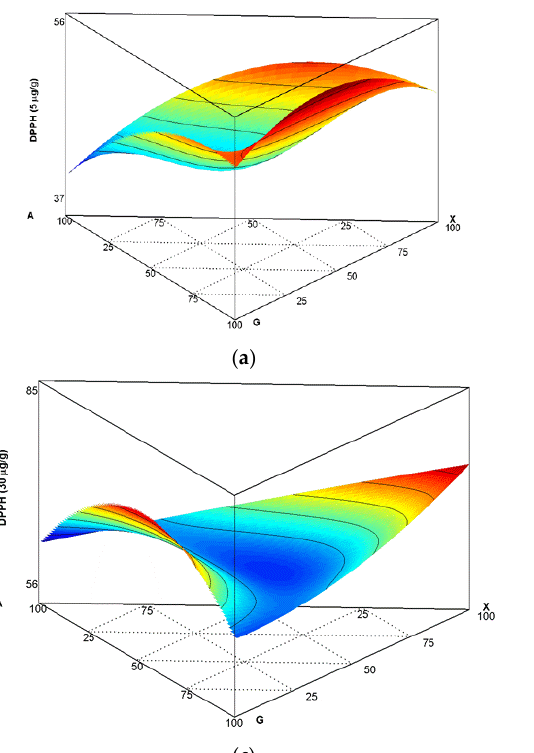
Figure 4. Antioxidant capacity of 2,2 difenil-1-picrilhidrazil (DPPH) radical inhibition: ( a ) 5 µg/mL, ( b ) 10 µg/mL, and ( c ) 30 µg/mL (sample), for matrix II, formed by A, G and X.